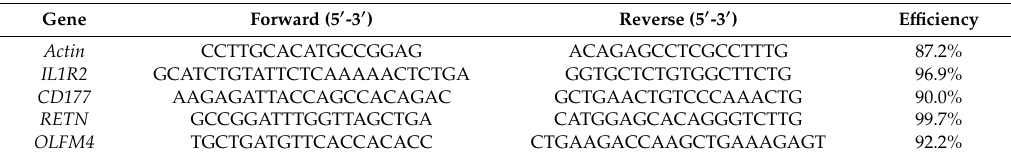
Table 1. Primers used for qPCR of genes from